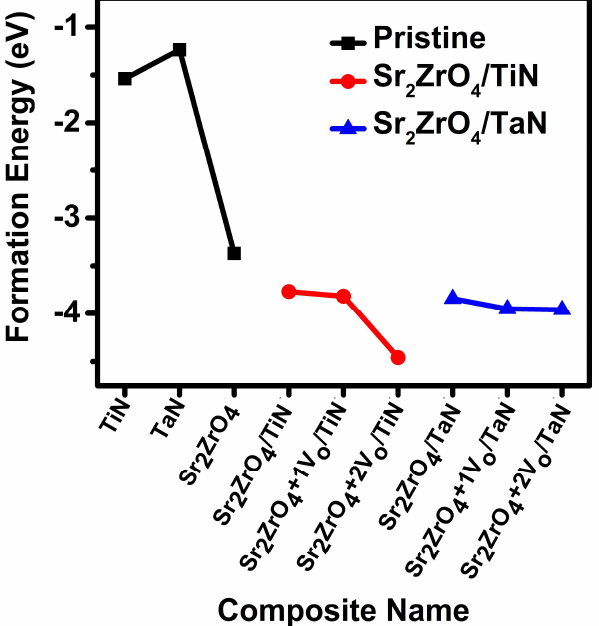
Figure 3. Formation energy of considered composites before and after making interfacial contacts.